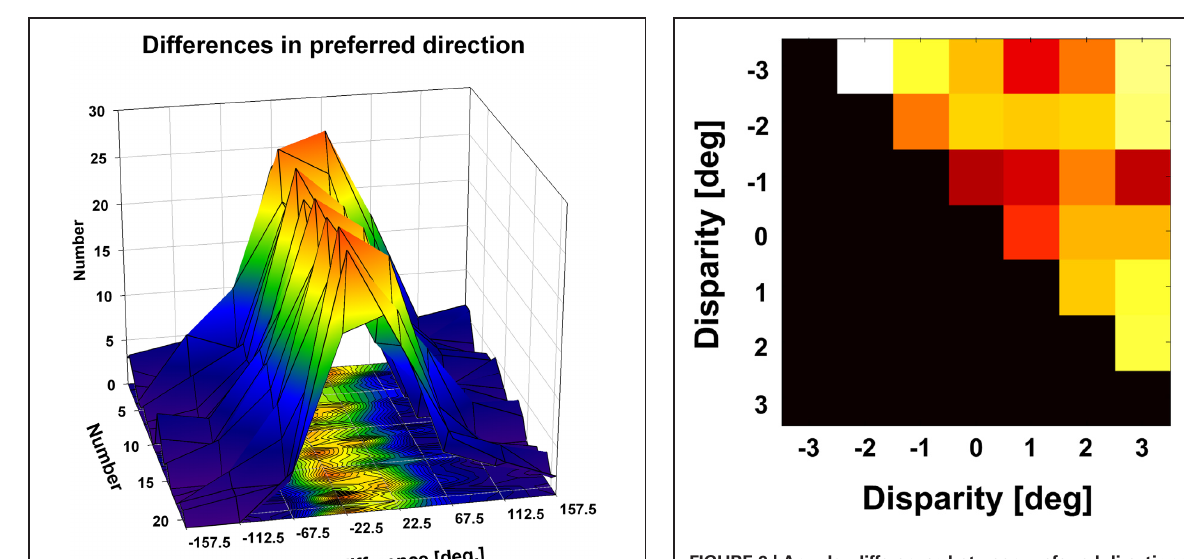
FIGURE 9 | Angular differences between preferred directions obtained at different disparities. We computed for each neuron on a pairwise basis the angular difference between PDs obtained at different disparities in case the tunings were significant (Rayleigh test, p < 0 . 05). For this analysis, we averaged for each pairwise comparison the angular difference. The grand average as computed for the full population is shown color coded. None of the values was different from zero (Bonferroni correction, t -test, p > 0 .